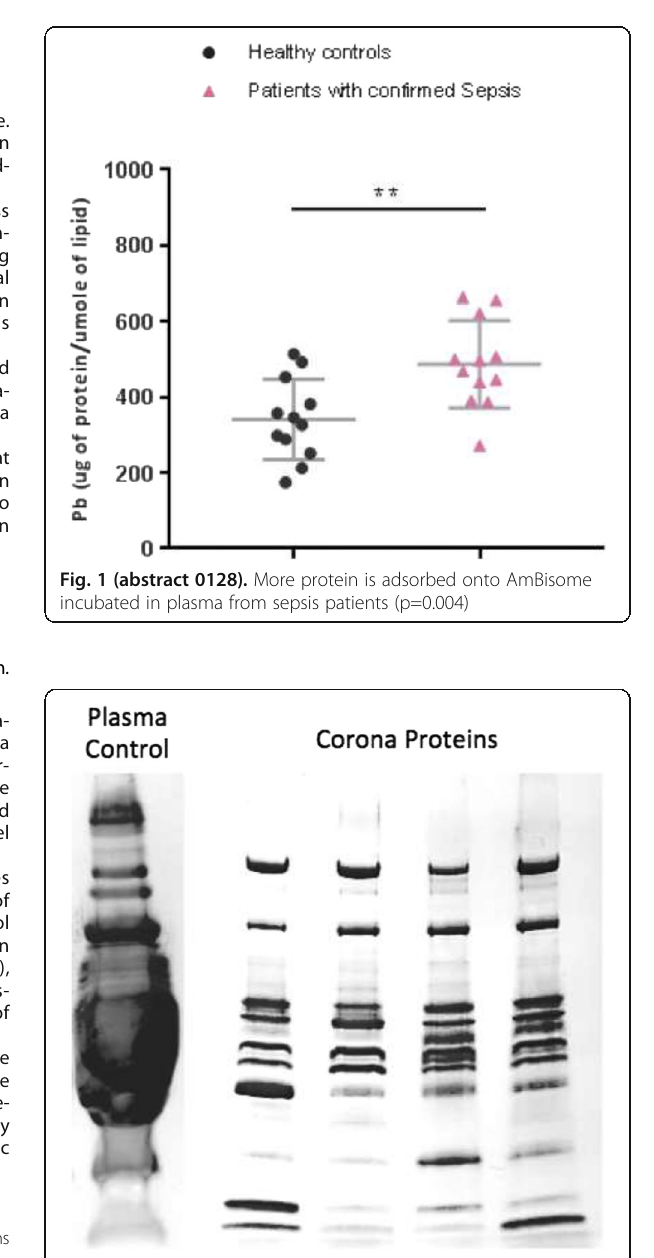
Fig. 2 (abstract 0128). SDS-PAGE Gel electrophoresis of protein corona compared to